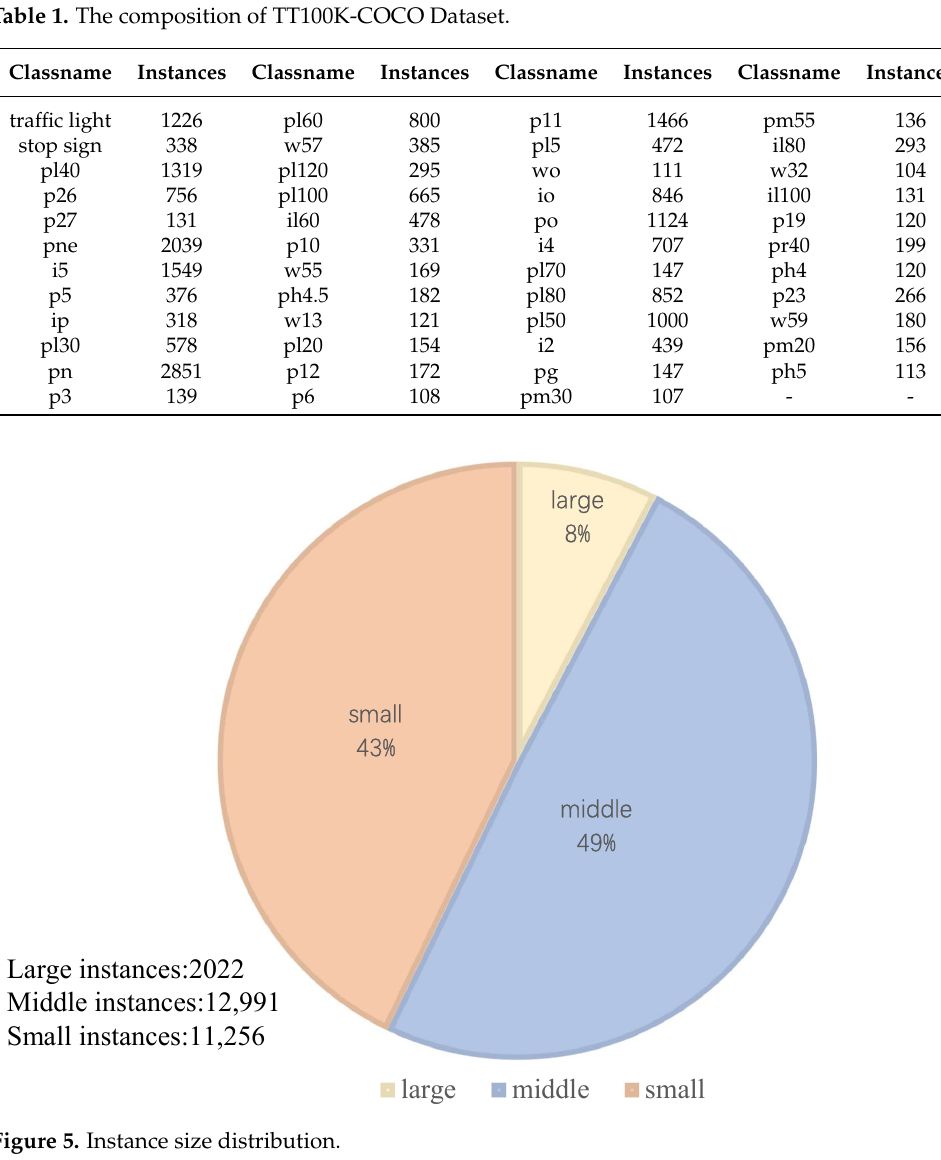
Table 1. The composition of TT100K-COCO Dataset.